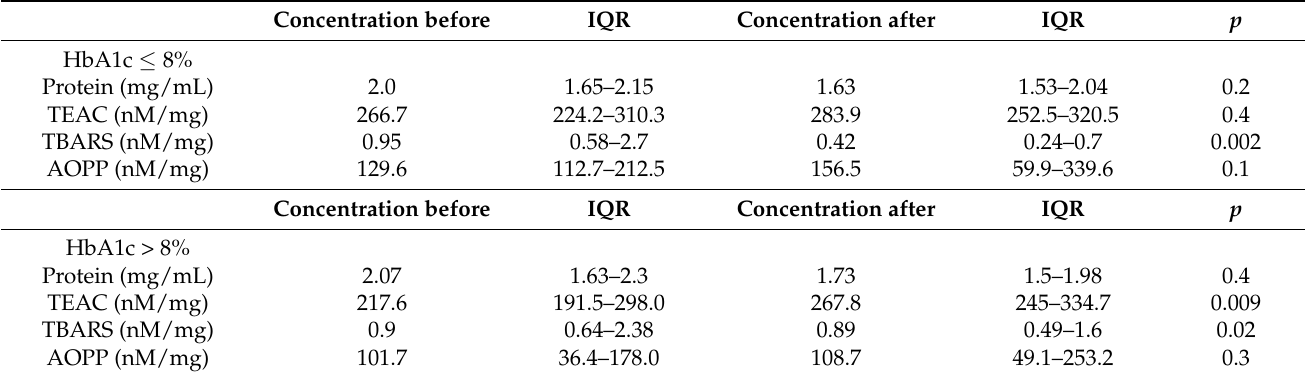
Table 6. Concentration of selected oxidative stress indicators in saliva before and after the application of the toothpaste in the HbA1c ≤ 8% and HbA1c > 8% subgroups. Median (IQR). The Wilcoxon signed-rank